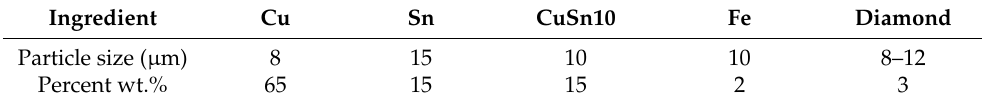
Table 1. The formula for Ultra-Thin Diamond Dicing Blade.